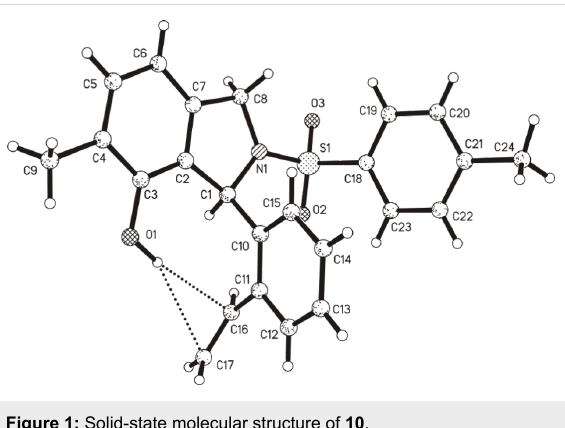
Figure 1: Solid-state molecular structure of 10